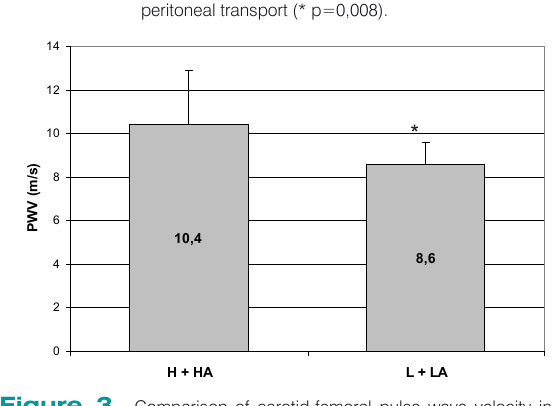
Figure 2. Comparison of carotid-femoral pulse wave velocity in peritoneal dialysis patients with H/HA and L/LA type of peritoneal transport (* p=0,008).